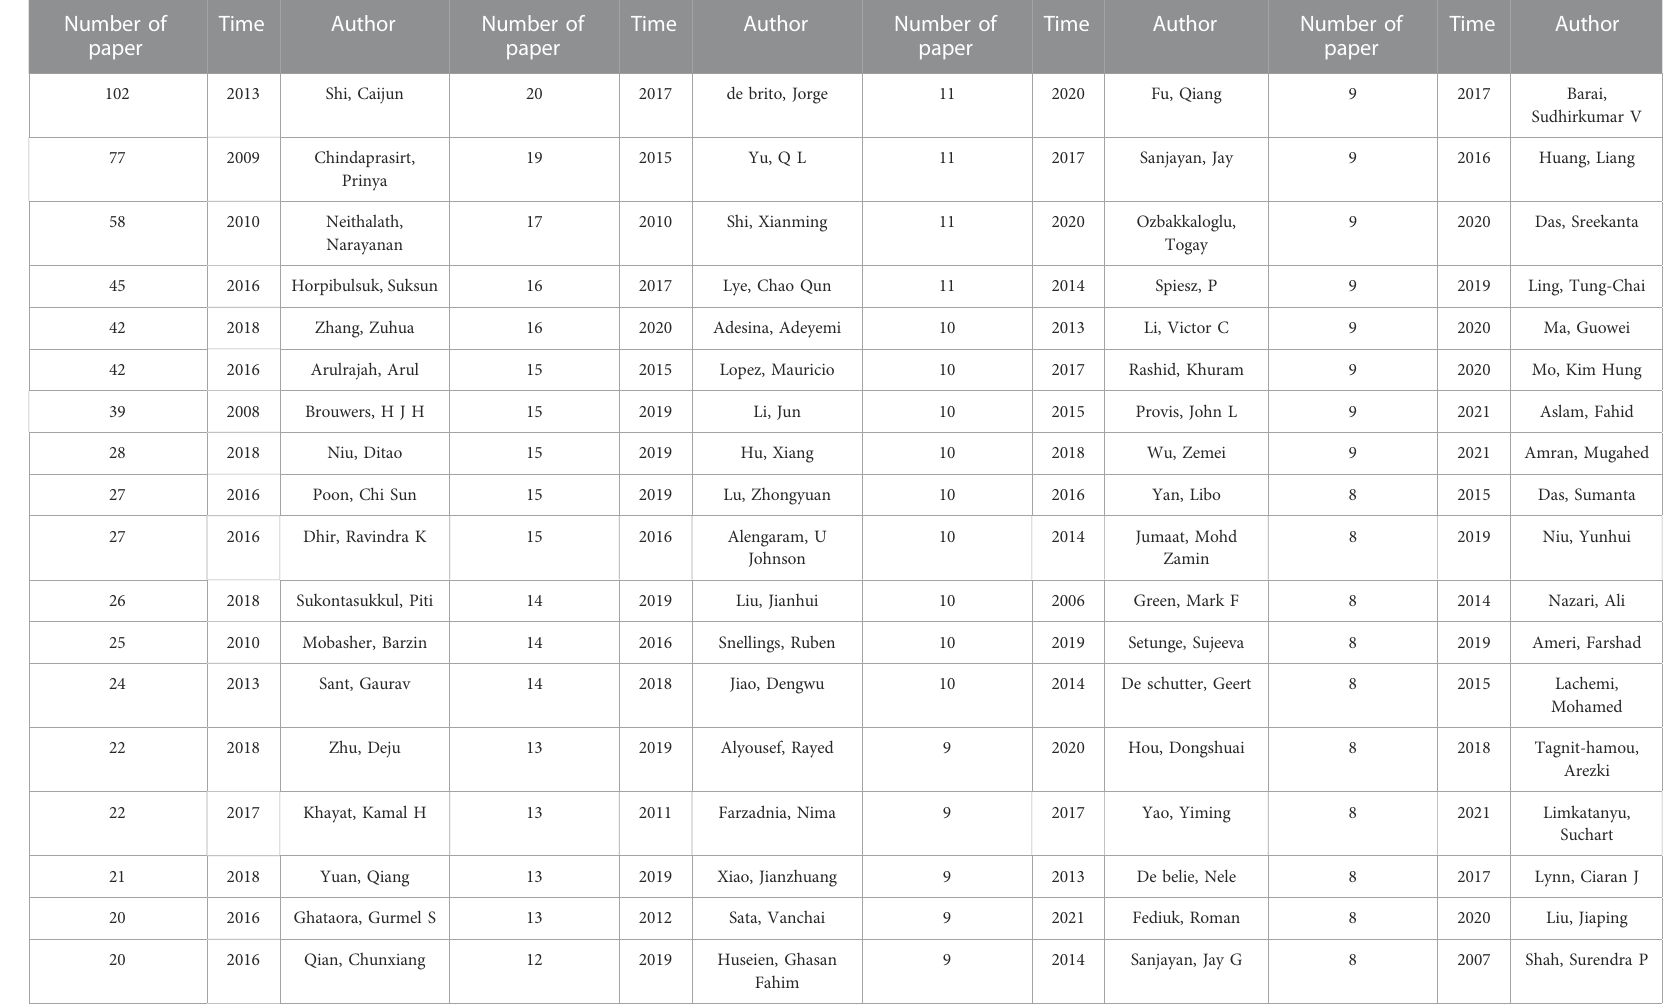
TABLE 6 Number of key authors and publications of ecological concrete from